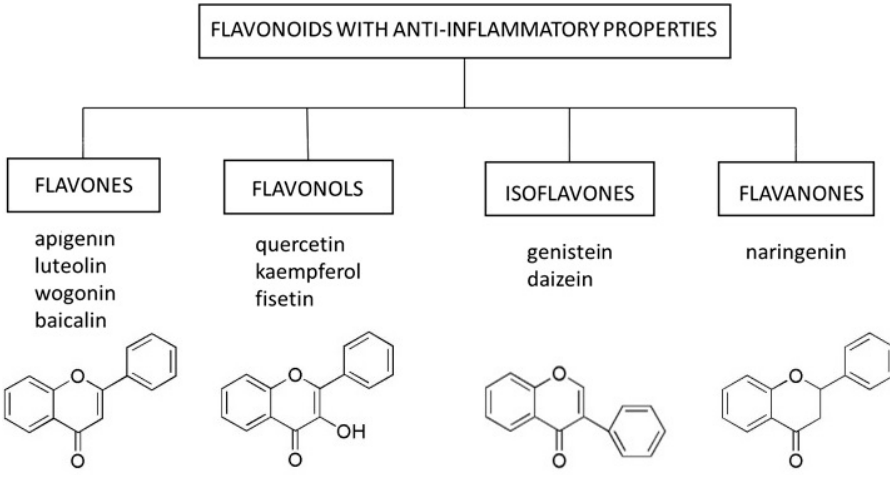
Figure 1. Select flavonoids with anti-inflammatory activity.